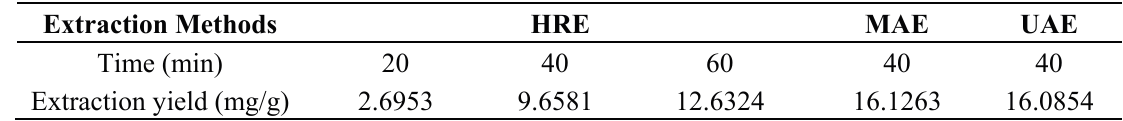
Table 3. Comparison of three different methods (HRE, MAE, and UAE) for extraction of SDG (IL concentration is 50% ( w / w ) and liquid–solid ratio is 20:1). Extraction Methods HRE MAE UAE Time (min) 20 40 60 40 Extraction yield